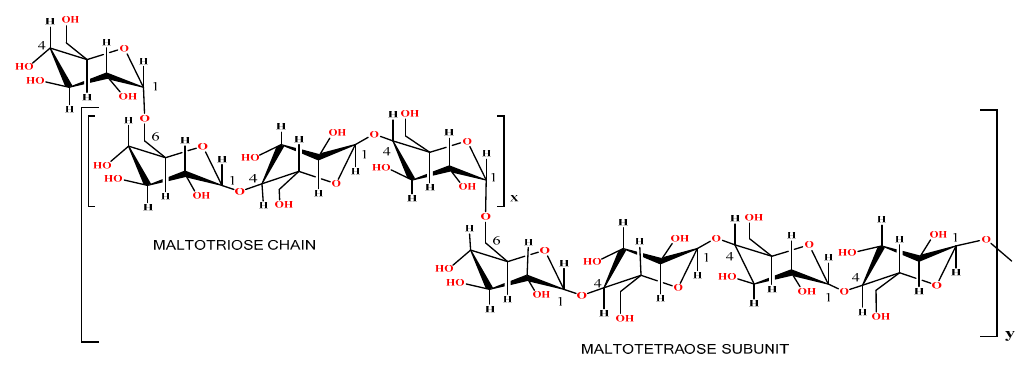
Figure 5. Molecular structure of pullulan with maltotriose and maltotetraose subunit.